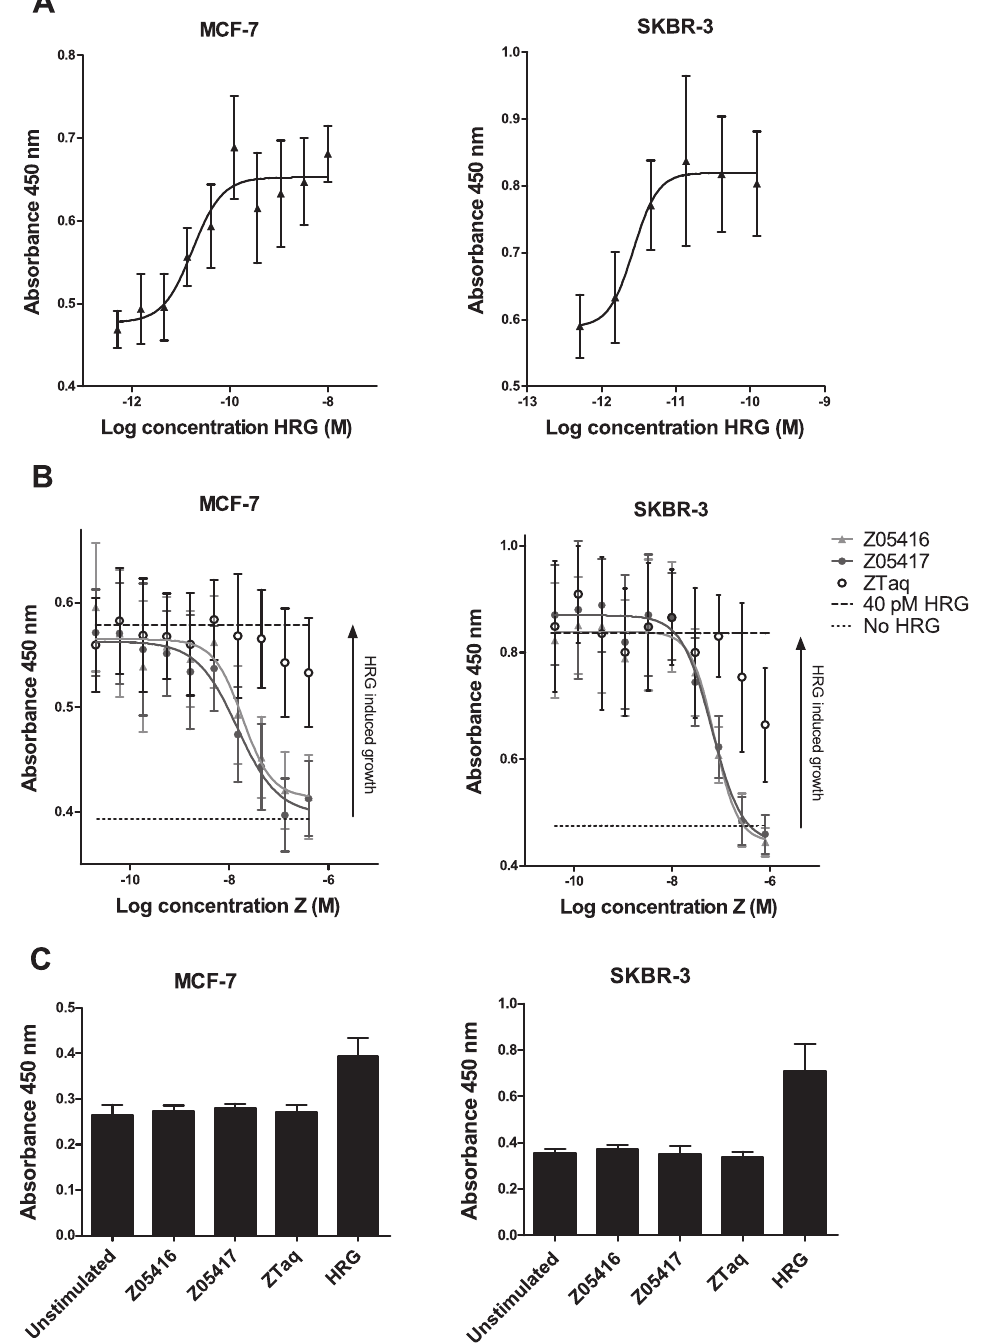
Figure 6. Analysis of cellular growth inhibitory effects of the HER3-specific Affibody molecules. Mean absorbance values at 450 nm 6 SD, which is proportional to the number of living cells, is given on the y-axis. A. Proliferation of MCF-7 and SKBR-3 cells grown in a dilution series of HRG. B. Proliferation of MCF-7 and SKBR-3 cells grown in 40 pM HRG and a dilution series of Affibody molecules Z05416, Z05417 or ZTaq. C. Proliferation of cells grown in medium containing 40 nM Affibody molecules, 0.04 nM HRG. Results are compared to unstimulated cells (no Affibody molecules or HRG added). doi:10.1371/journal.pone.0040023.g006 potential effects on HER3-positive cancer cell lines in vitro. The downstream signalling proteins Erk and Akt, and finally, inhibited results demonstrated that the new binders recognized native the heregulin-induced proliferation of two HER3-positive cancer HER3 on several cancer cell lines, blocked the natural ligand cell lines. heregulin from binding to the receptor on the cell surface, decreased the phosphorylation of HER2 and HER3 as well as the